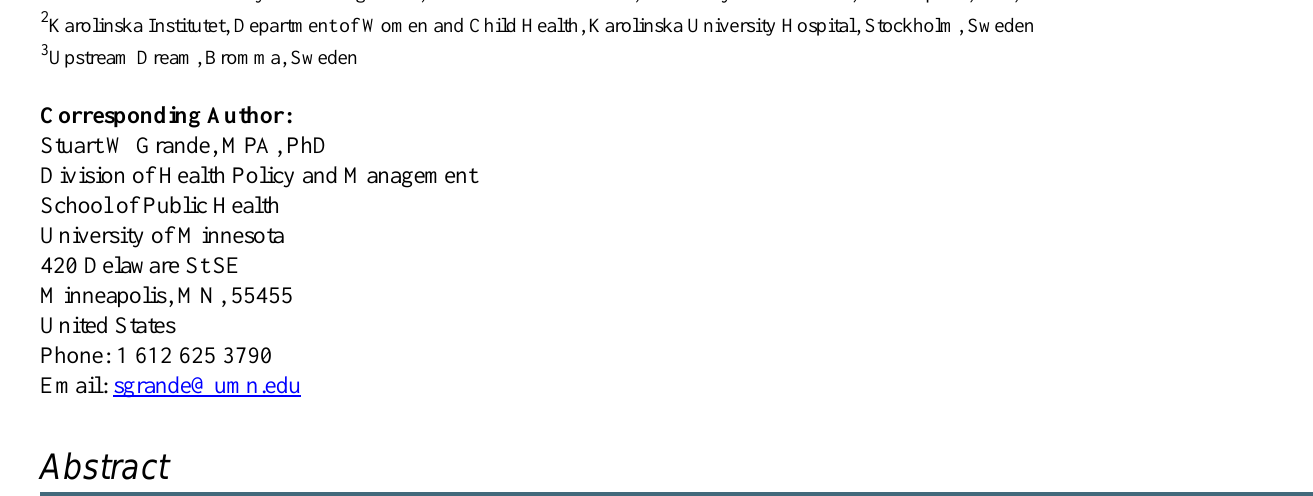
juvenile arthritis; interviews; health communication; patient